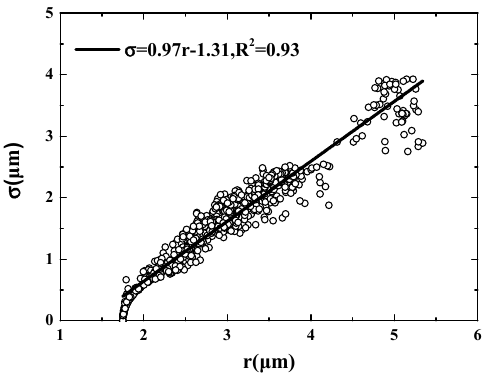
Figure 5. Relationship between standard deviation ( σ ) and mean radius ( 𝑟 ) of cloud droplet size distribution.